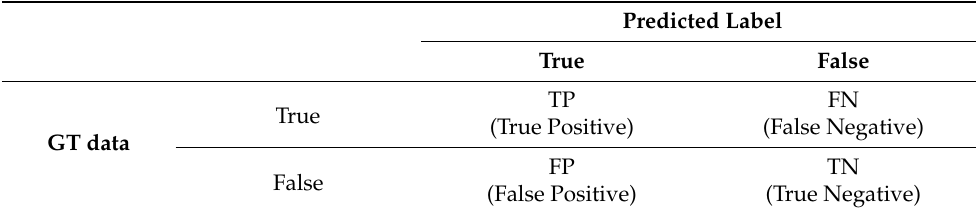
Table 1. Confusion matrix.